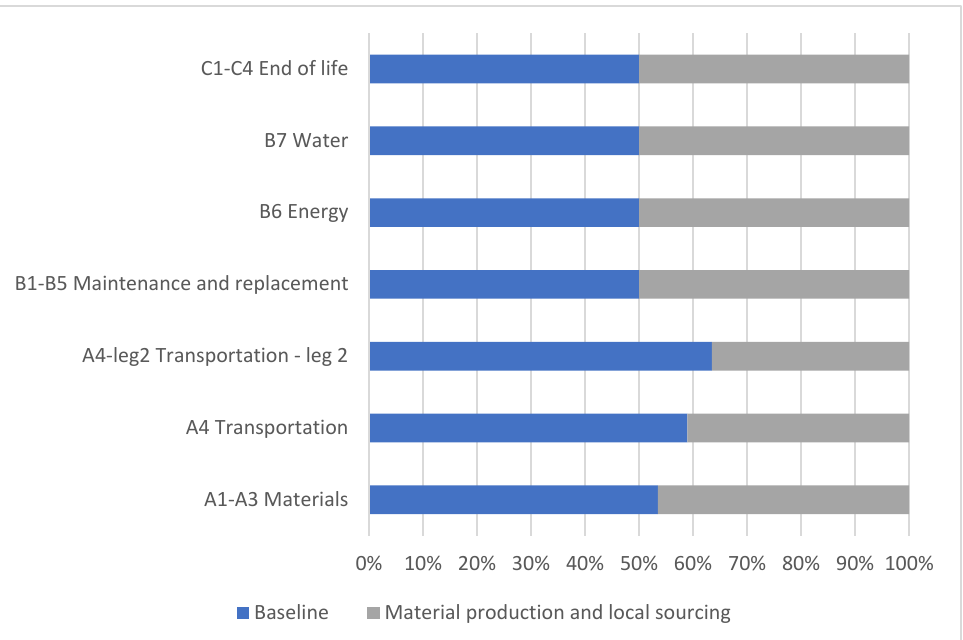
Figure 8. Comparison of baseline with the material production and local sourcing.